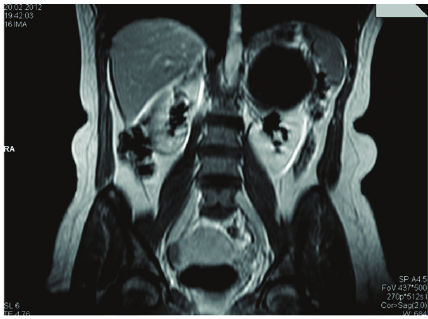
Figure 2: Multicystic architecture with dilated spaces lined by flattened lining cells (HE ×20 ).